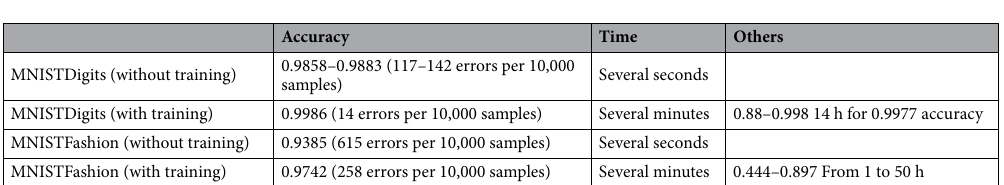
Table 1. Summary of accuracy and timing results obtained by shallow learning processing of the original handwritten digits MNIST dataset 82 and the Fashion-MNIST dataset 83 using WETCOW inspired algorithm and test implementation based on the ideas of critically synchronized